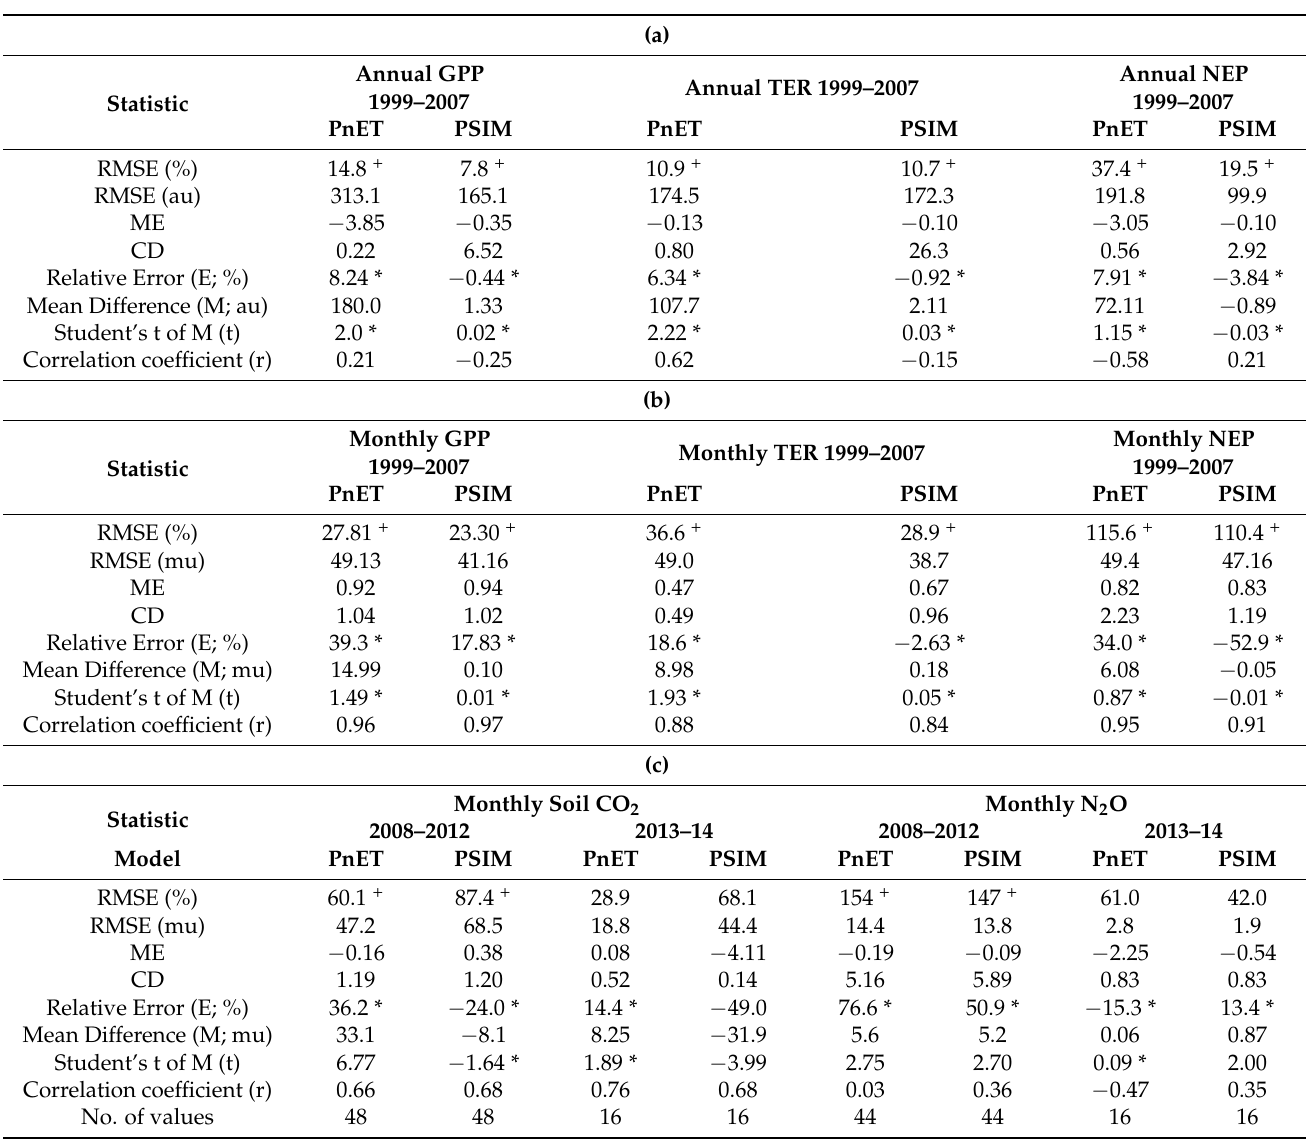
Table 5. Statistical analysis using ModEval v 2.0 [46] for comparison of CO 2 fluxes simulated by PnET and PSIM with (a) annual ( n = 9) and (b) monthly ( n = 108) eddy covariance measurements of GPP, TER and NEP, (c) monthly soil